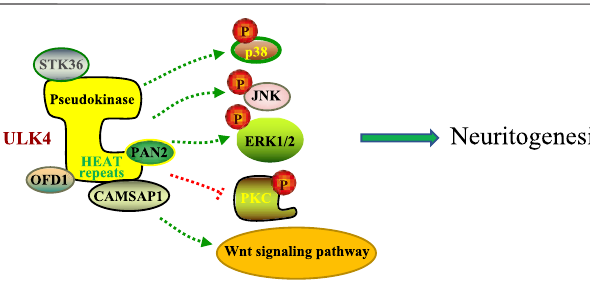
FIGURE 2 | A schematic representation of altered activities of multiple signaling pathways including p38 MAPK, JNK, ERK1/2, PKC, and Wnt signaling pathways by ULK4. These alterations contribute to de fi cient neuritogenesis, a common feature frequently represented by human mental